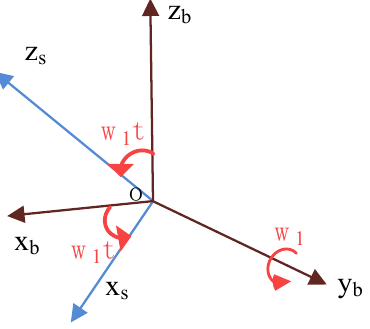
Figure 2. The b-frame and s-frame transformation diagram.